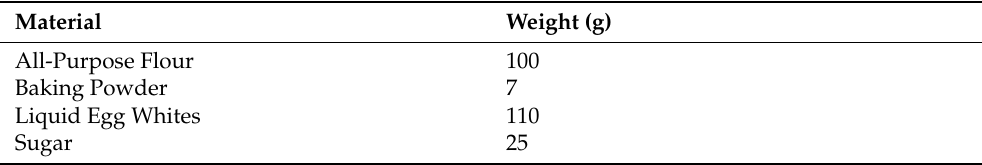
Table 3. Formulation of Bahulu